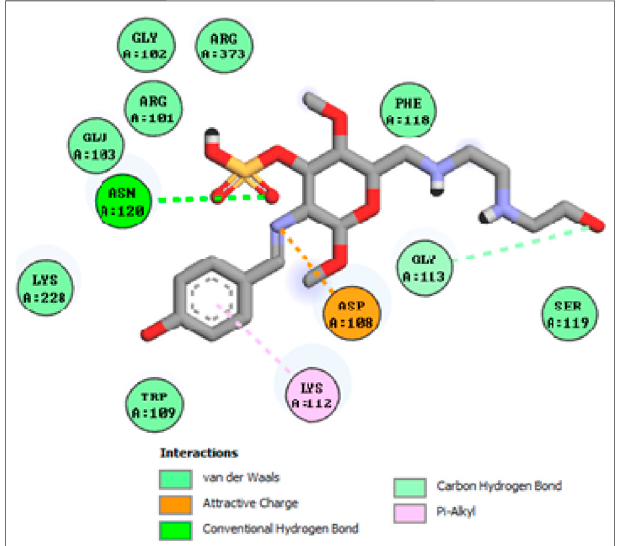
FIGURE 10 | Interaction of compound 2f in the binding pocket of 1Z11